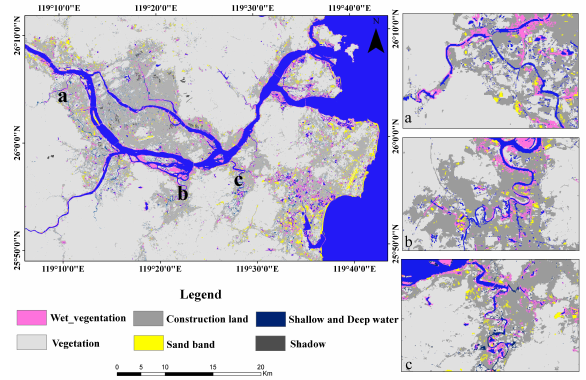
Figure5. The results of wetlands classification